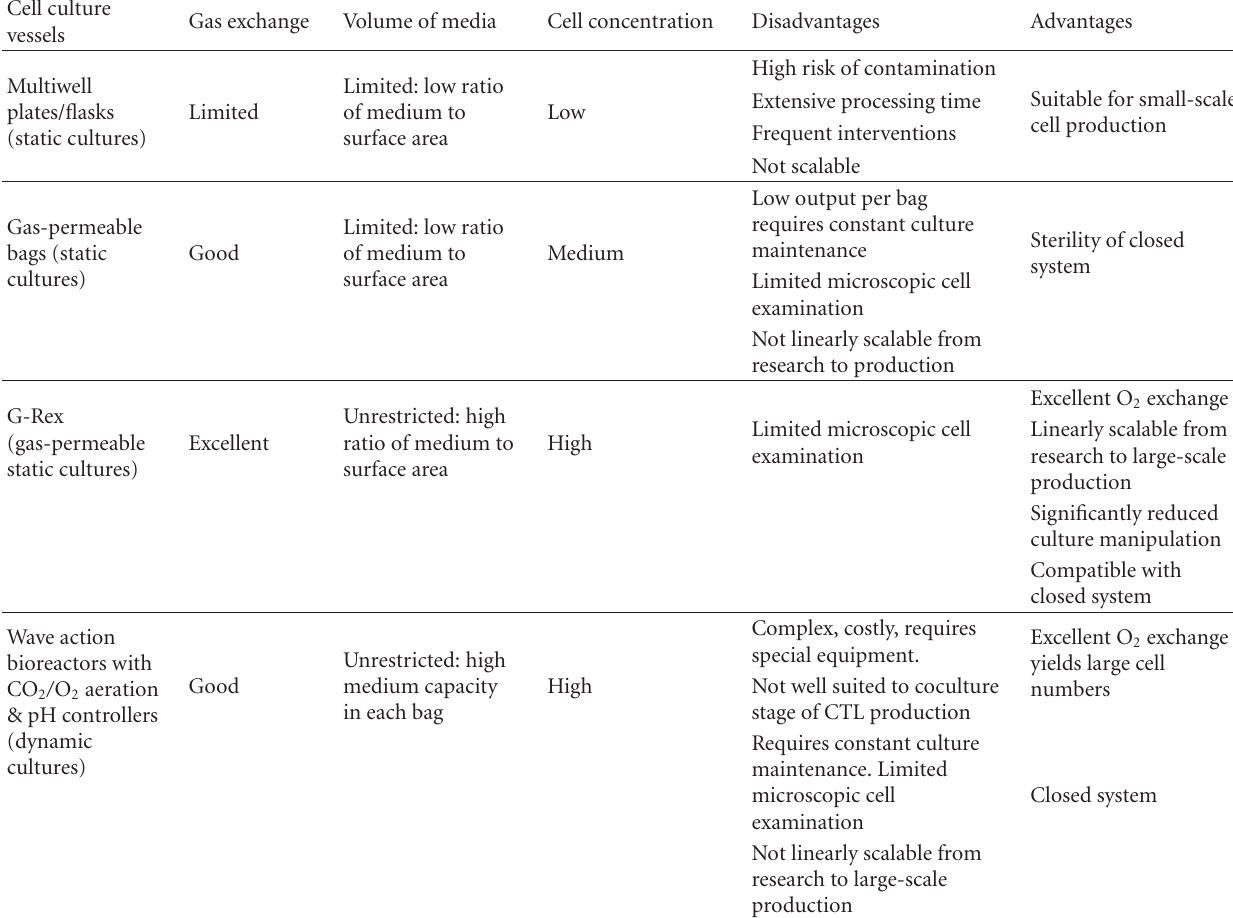
Table 1: Suitability and properties of di ff erent culture vessels for T cell